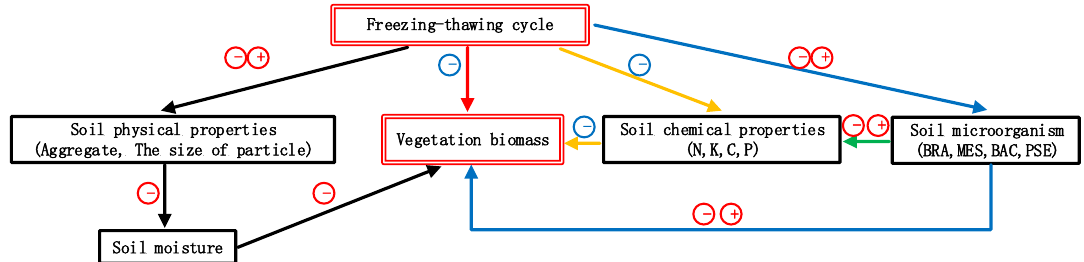
Figure 1. The theories and assumptions of the direct and indirect effects of the freezing – thawing cycle (FTC) on alpine vegetation. The lines with different colors indicate different ways that the freezing and thawing cycle affect vegetation. The ‘+’ sign indicates a positive correlation, the ‘−’ sign indicates a negative correlation, the blue symbol indicates that the corresponding theory has been confirmed, and the red symbol indicates that the corresponding theory is unconfirmed.